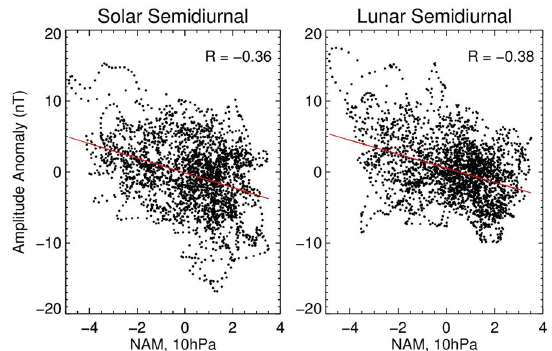
Fig. 2 Scatter plot between the anomalies in S 2 and L 2 geomagnetic tides versus the Northern Annular Mode (NAM) at 10 hPa. Results are restricted to the period of 15 December to 1 March for all the available data between 1980 and 2020. The S 2 and L 2 tidal anomalies are plotted against NAM with a lag of 10 and 0 days,